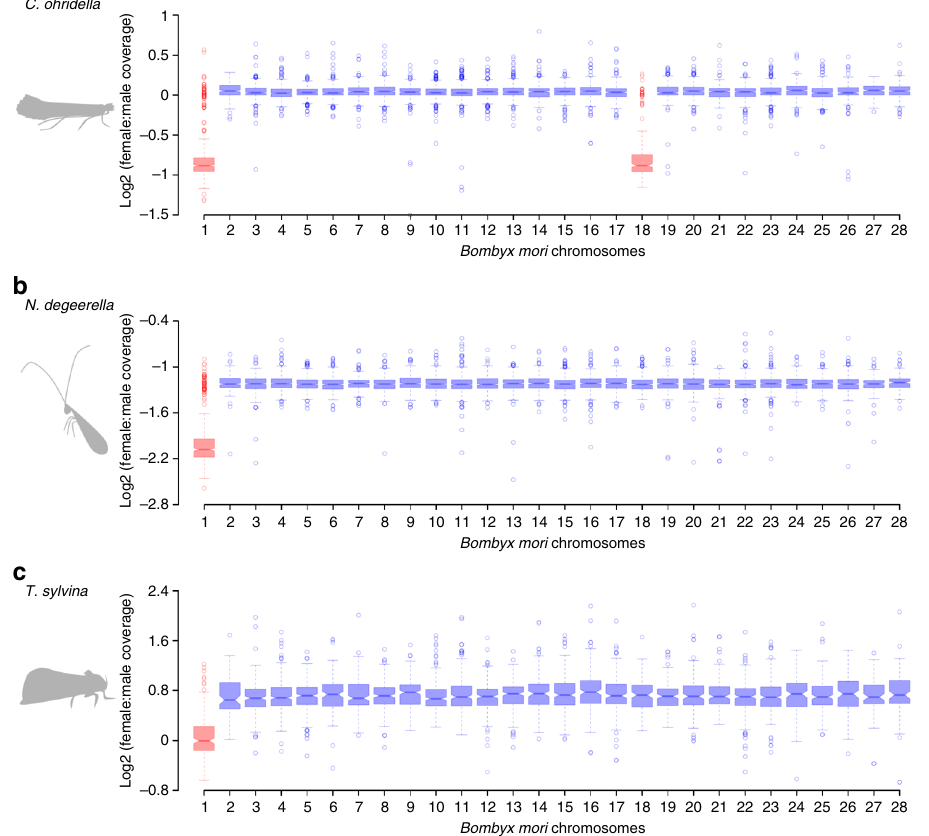
Fig. 2 The Z chromosome of B. mori is homologous to that of the other species. Cameraria ohridella has additionally acquired a neo-Z chromosome (Chr. 18). For each species, scaffolds were assigned to one of the B. mori chromosomes based on their gene content. The Log2 of the female to male coverage ratio of each chromosome is shown for a C. ohridella , b N. degeerella , and c T. sylvina . Scaffolds mapping to the B. mori Z chromosome, and the neo-Z chromosome of C. ohridella , are in red, those mapping to the autosomes are in